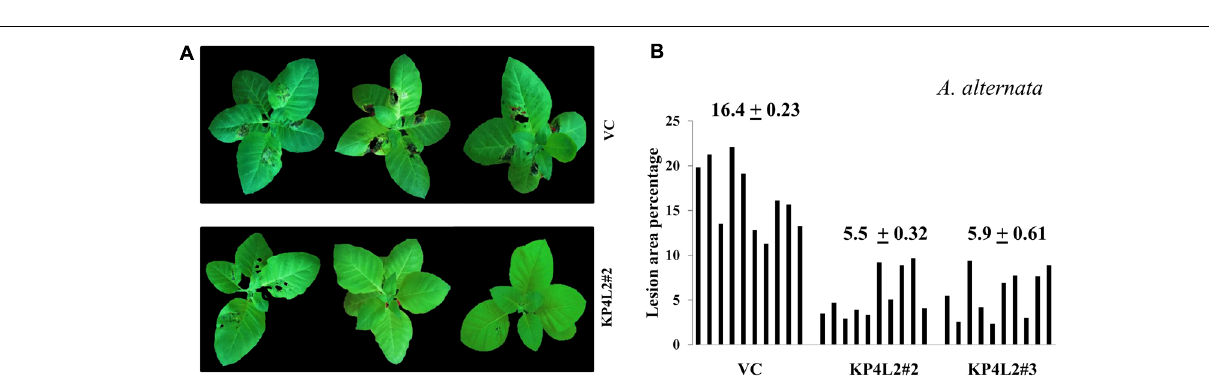
FIGURE 10 | Whole plant assays against A. alternata. (A) Representative images of transgenic plant line KP4L2#2 along with VC 13 dpi. Ten plants each of KP4L#2, KP4L2#3, and VC were sprayed with conidial suspension of the fungus (10 7 CFU/mL) to initiate infection. (B) The graph represents lesion area percentage showing symptoms ± SE calculated on the 13th